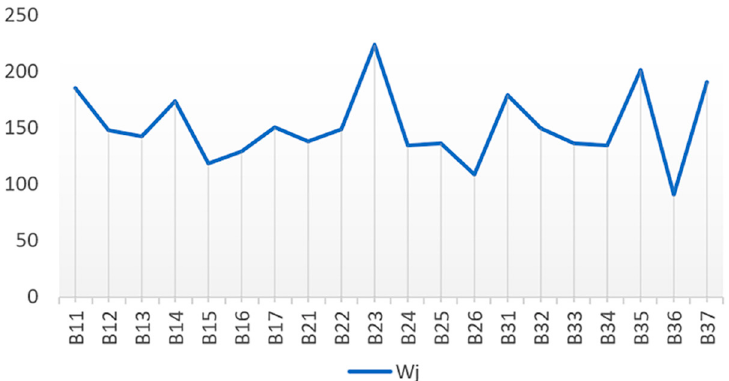
Figure 8. Sorting result of quality design importance.